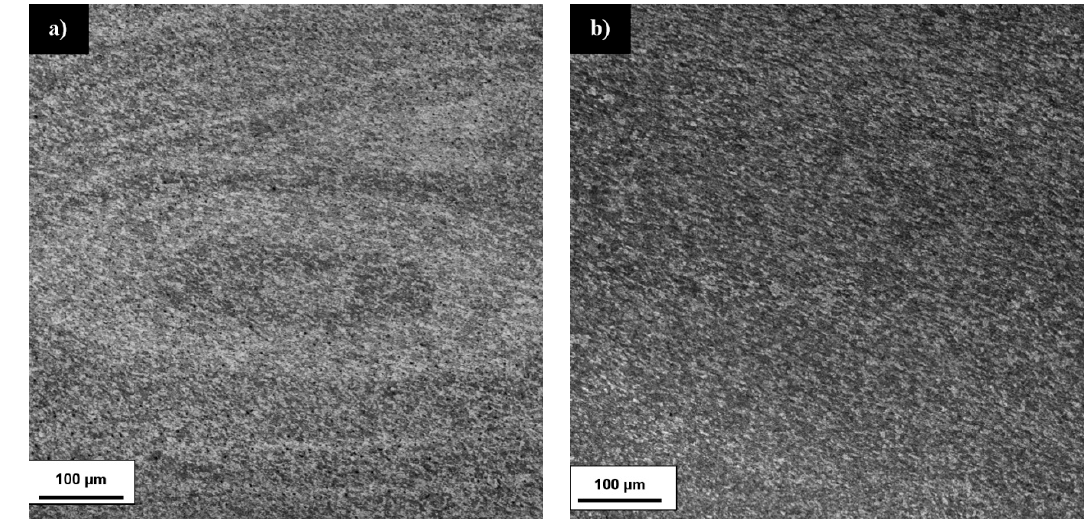
Figure 4. Light microscopy image of the stir zone in the ( a ) A42 sample and ( b ) A81 sample.